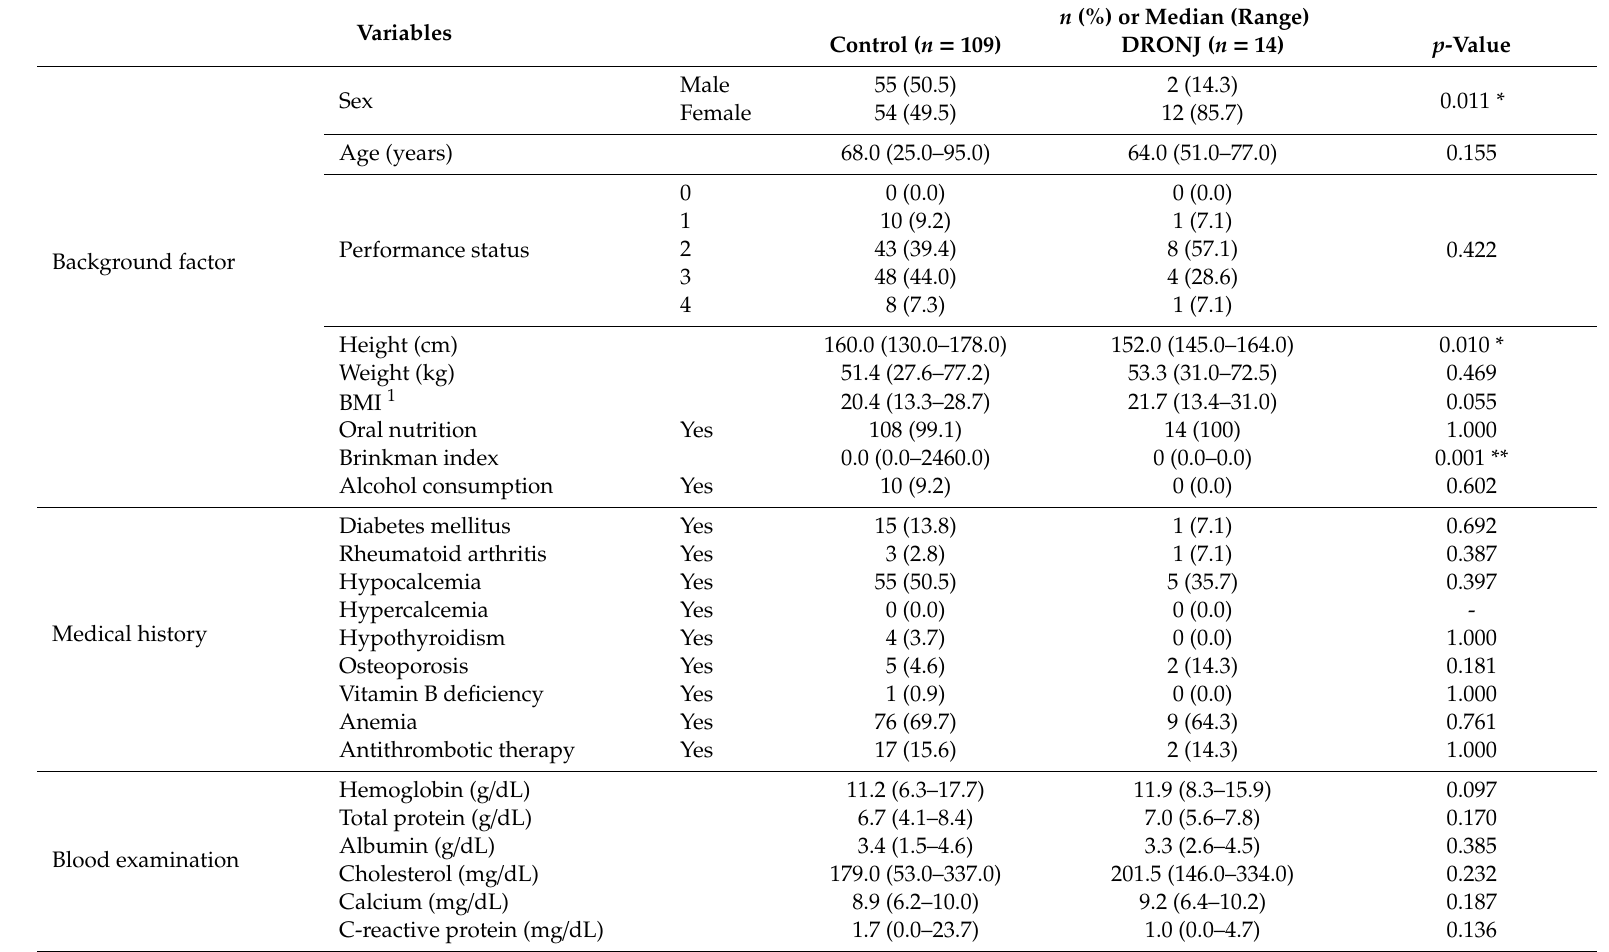
Table 2. Comparison between the DRONJ and non-DRONJ groups after